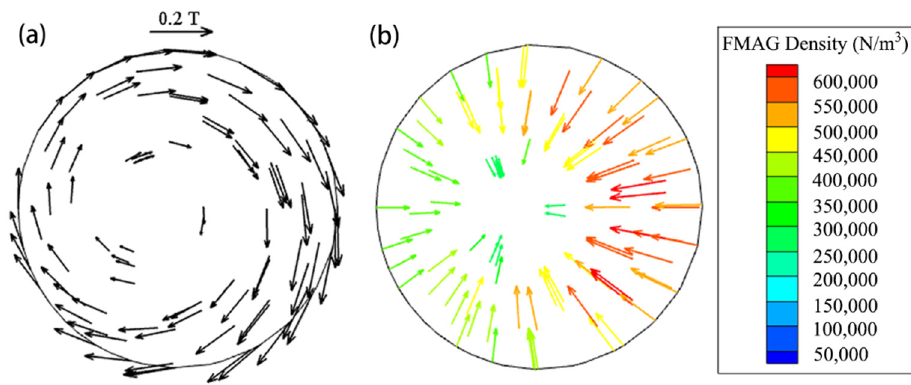
Figure 10. Vector contour in channel cross section: ( a ) magnetic field; ( b ) electromagnetic force.